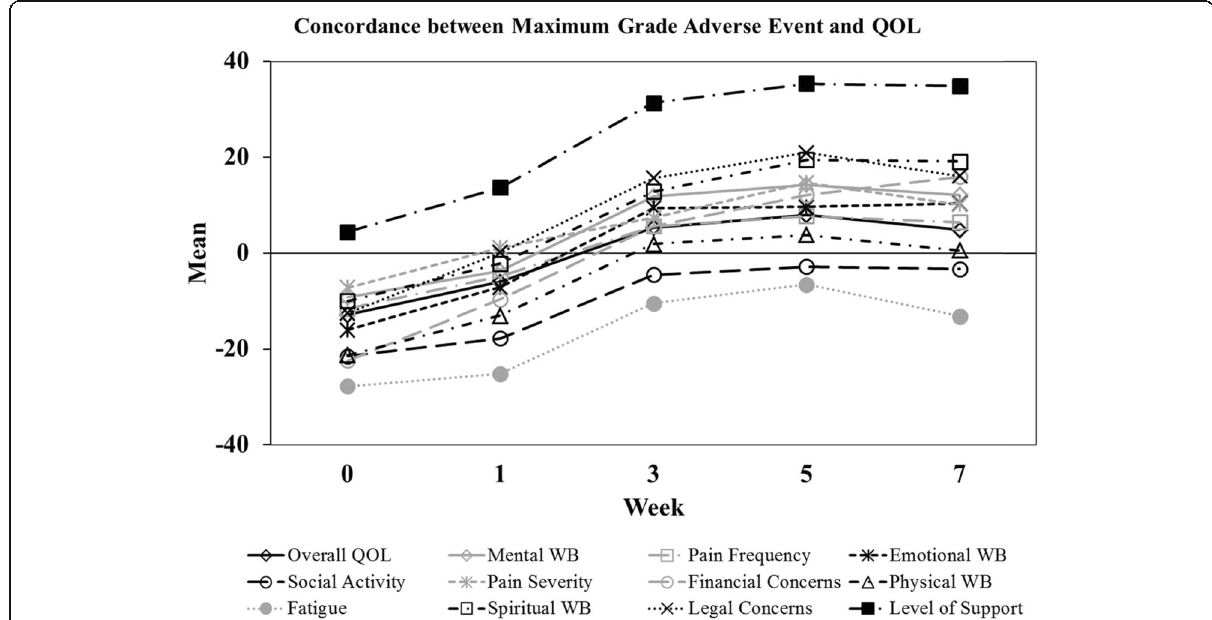
Fig. 3 Bland-Altman analysis to assess agreement between AE grade and LASA score at each time point. Both were transformed to 0 to 100 scale, and LASA score was subtracted from AE